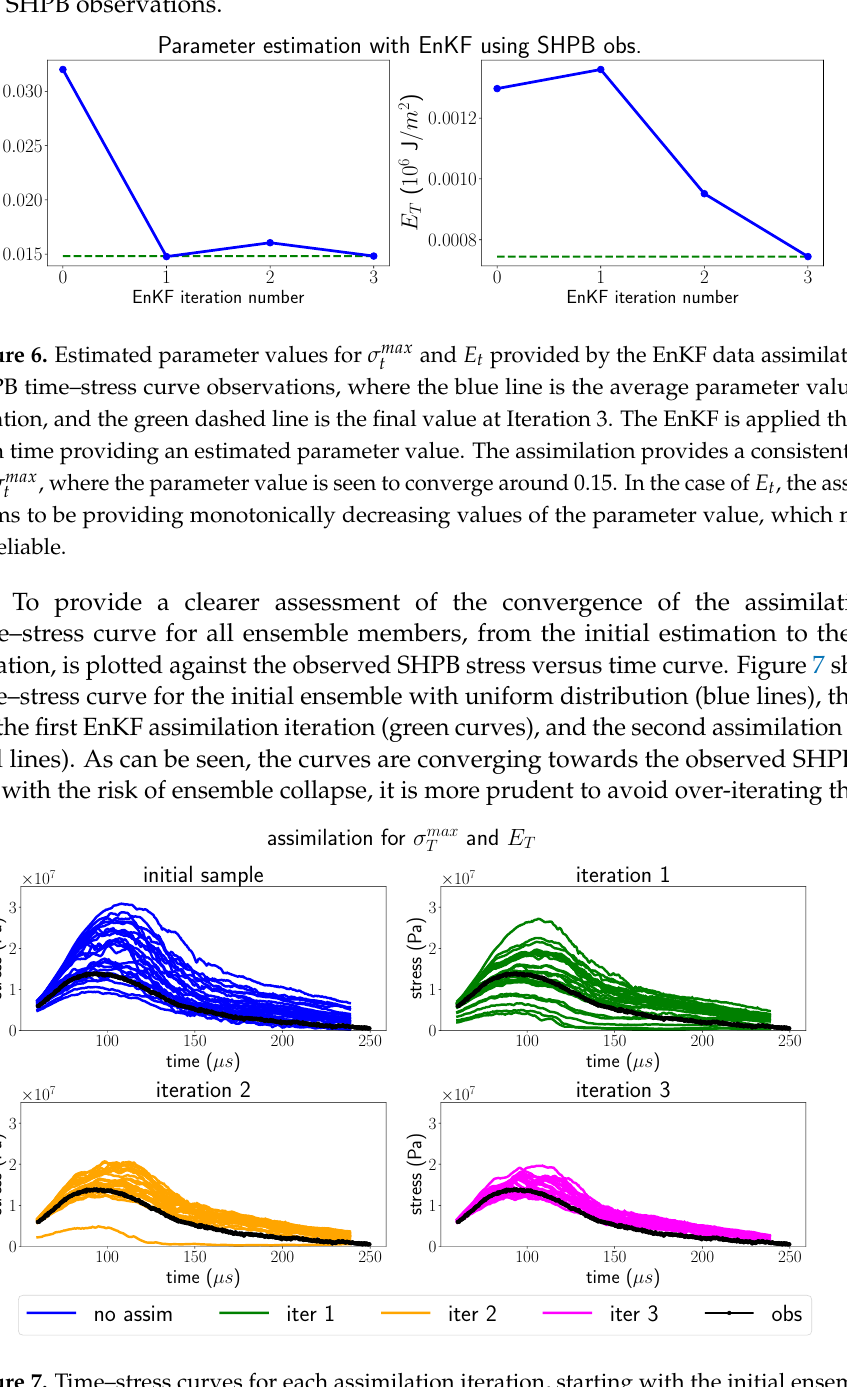
Figure 7. Time–stress curves for each assimilation iteration, starting with the initial ensemble of 25 members (top-left plot, blue lines), first assimilation iteration (top-right plots, green lines), second iteration (bottom-left plot, yellow lines), and third iteration (bottom-right plot, magenta lines), as well as the observations (black line in all